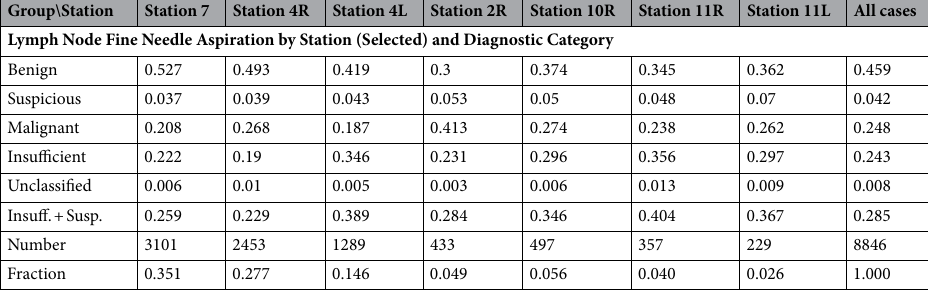
Table 2. Lymph node cohort by mutually exclusive grouping and anatomical location (selected).